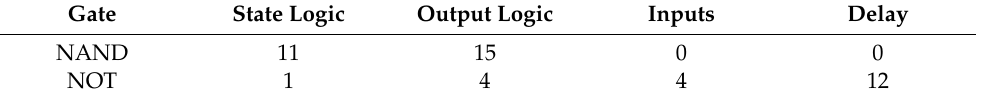
Figure 14. Block diagram of the asynchronous state machine.